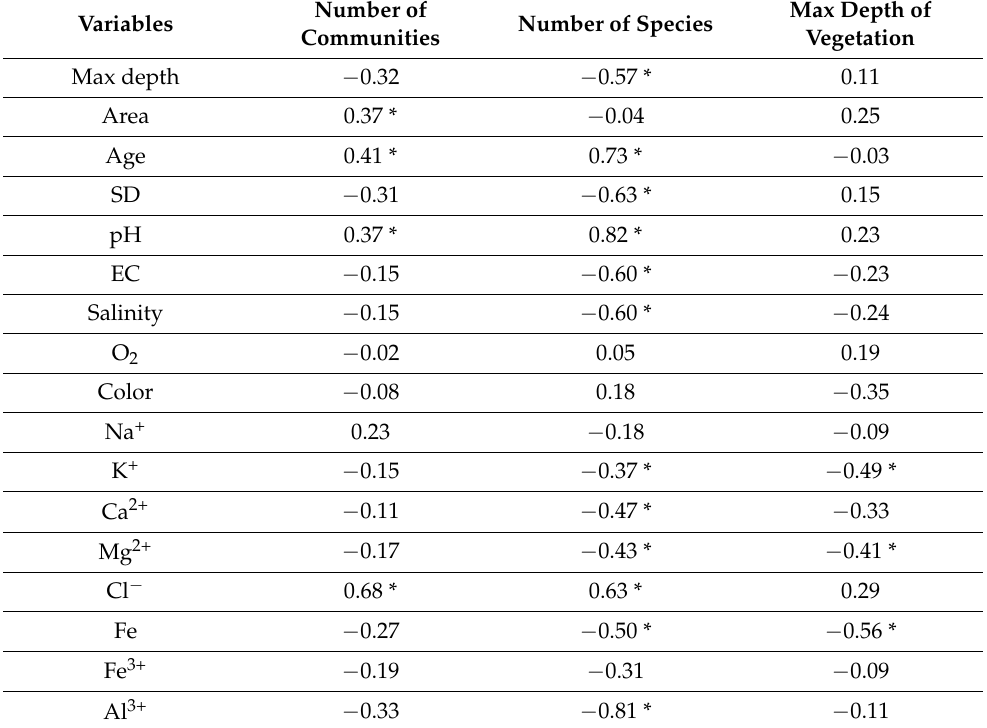
Table 2. Spearman’s rank correlations (r s ) between habitat properties and macrophyte characteristics. * Significant correlations at the significance level of p <